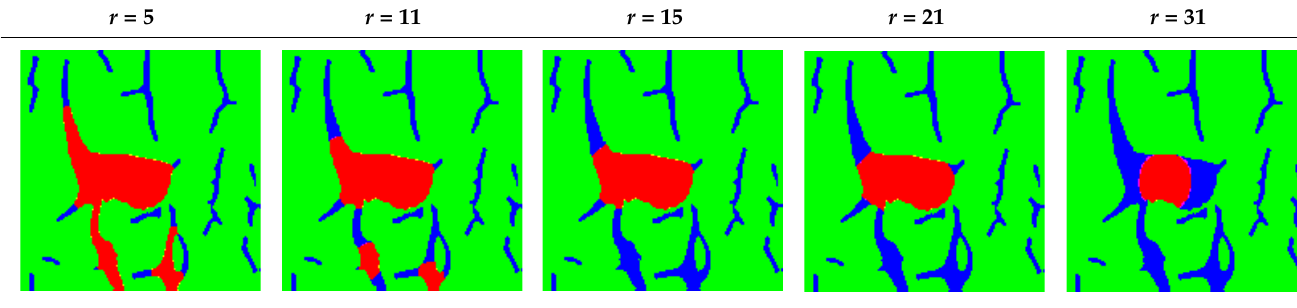
Table 6. Input image (Table 5) segmentation results for different radiuses of the kernel K .